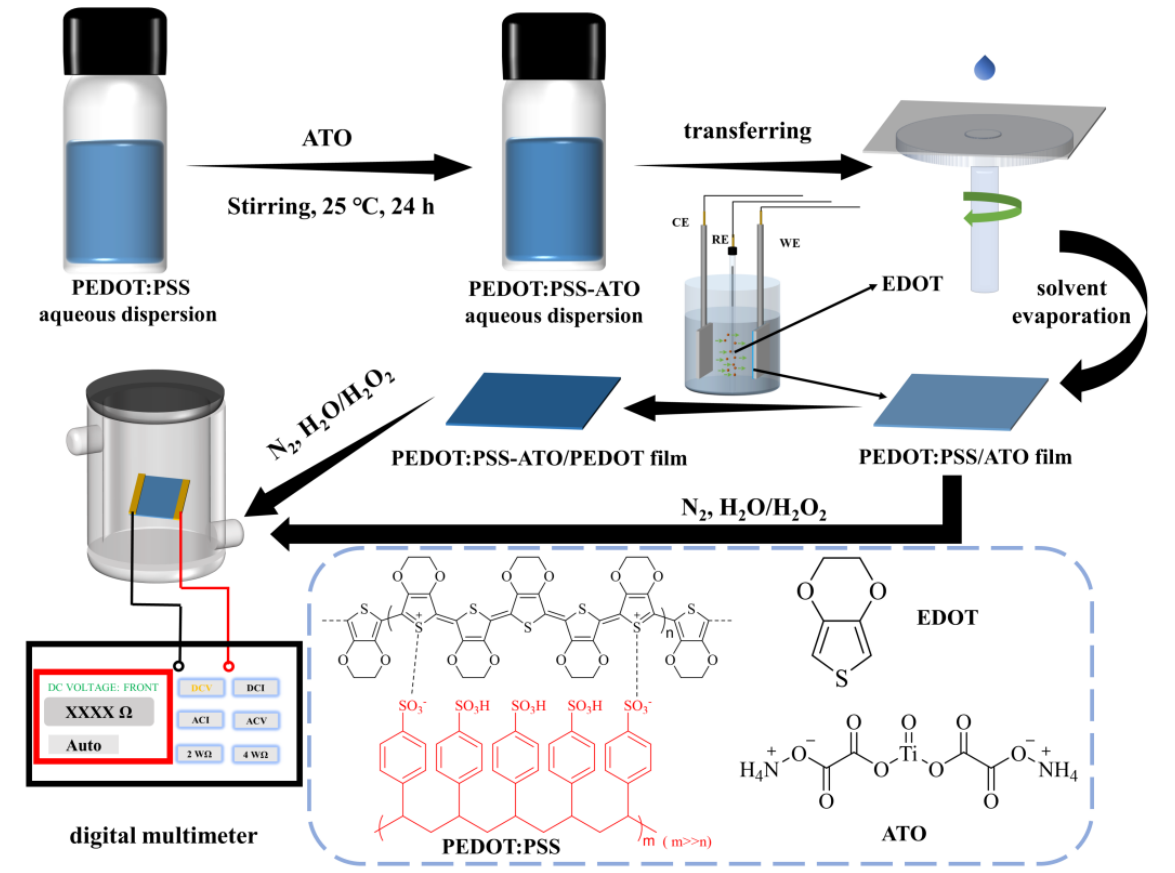
Figure 1. Schematic of the preparation and detection process of PEDOT:PSS-ATO and PEDOT:PSS- ATO/PEDOT films. CE: counter electrode; RE: reference electrode; WE: working electrode.